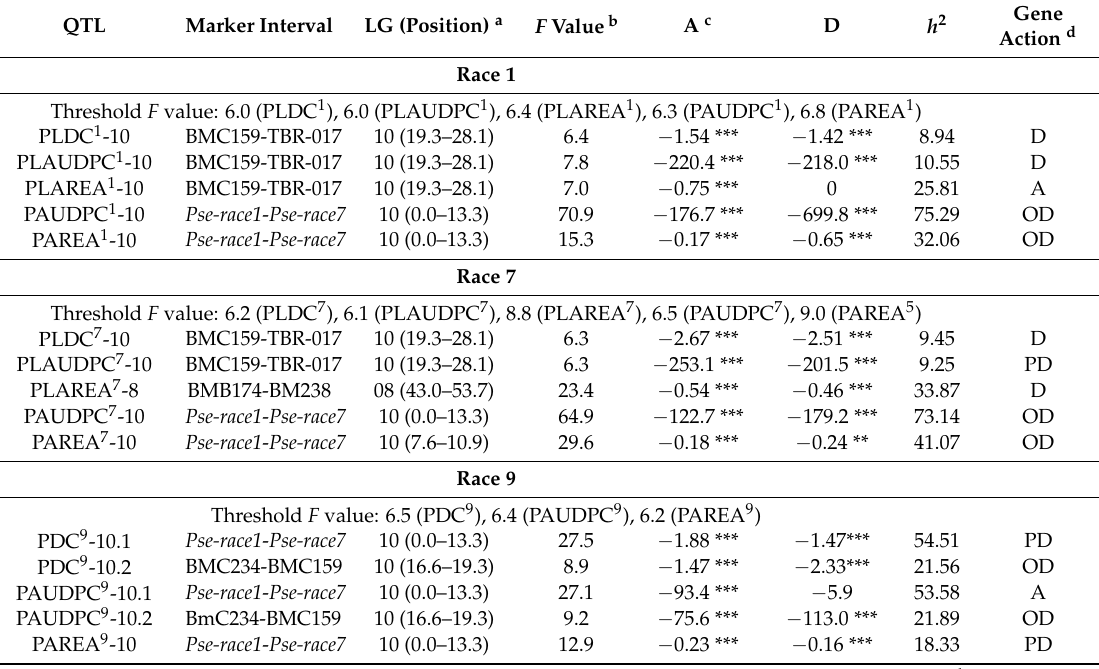
Table 6. Single-locus effect QTLs detected for primary leaf and pod resistance of Psp races 1, 7 and 9 in the UI3A52 F 2